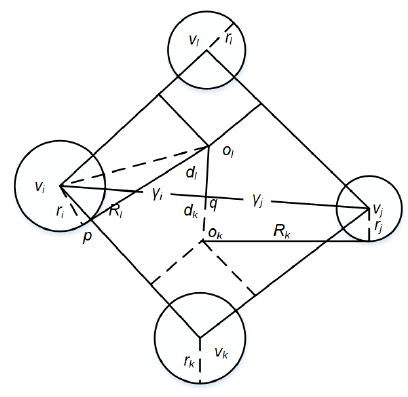
Figure 4. Power cell and its dual triangle. Where R l and R k are triangle power radius of ∆ v i v j v k and ∆ v i v j v l . d l and d k are vertical distances from the triangle center o l and o k to edge [ v i , v j ], respectively. γ i and γ j are the distances between v i and q , v j and q , respectively.